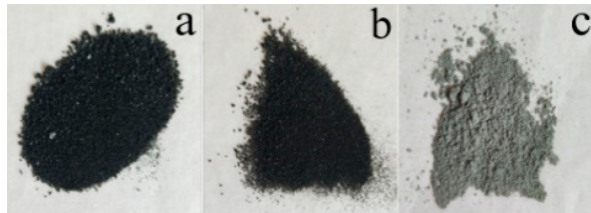
Figure 4. The morphology of the carbonized product under different pyrolysis atmospheres: ( a ) nitrogen; ( b ) vacuum; ( c ) air.